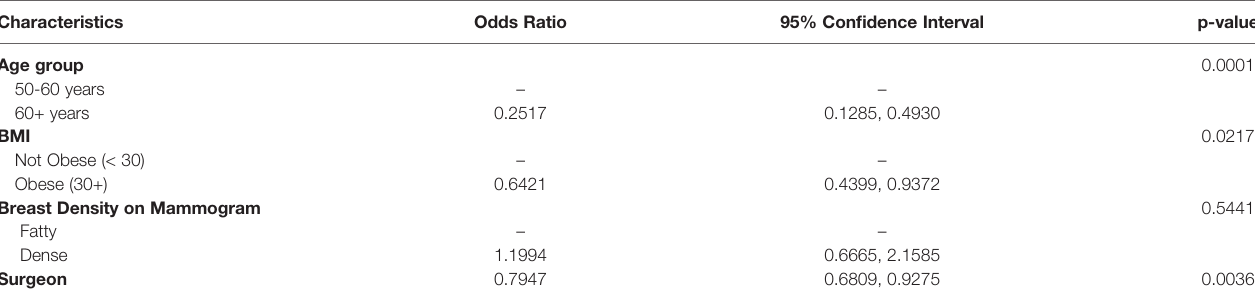
TABLE 2 | Multivariate analysis of predictors of obtaining preoperative